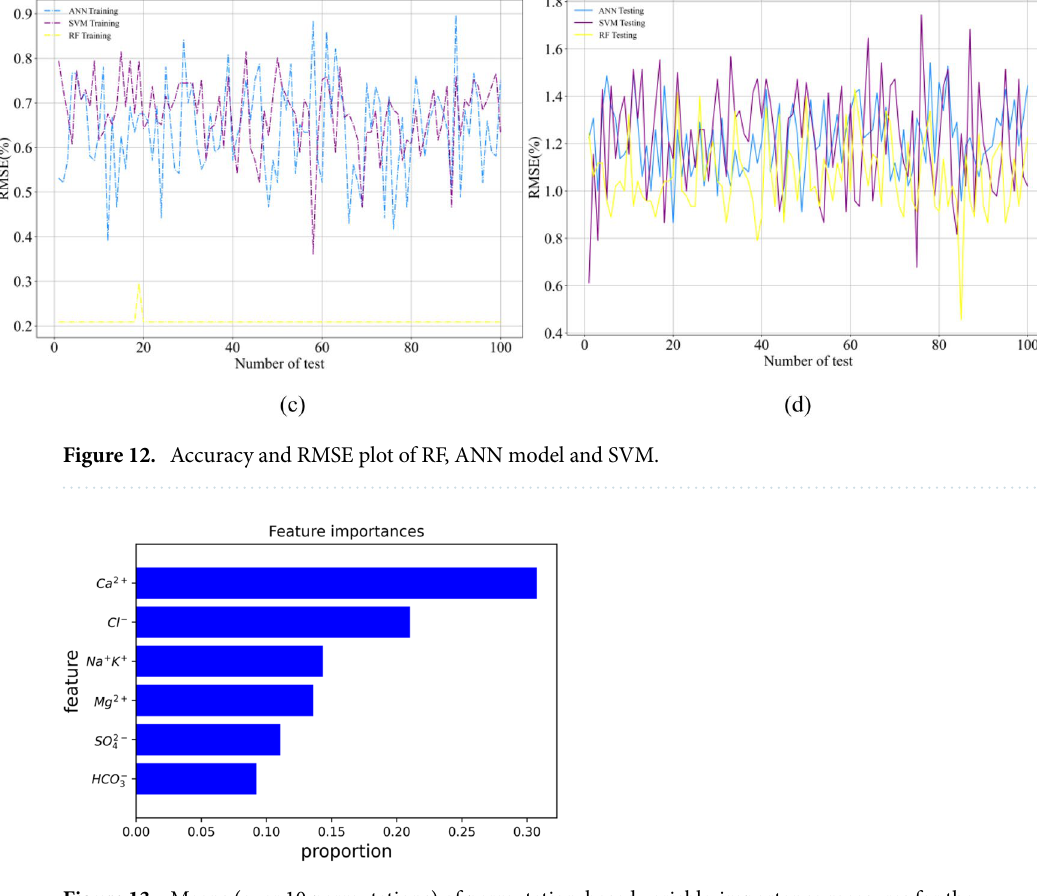
Figure 13. Means (over 10 permutations) of permutation-based variable-importance measures for the explanatory variables included in the random forest